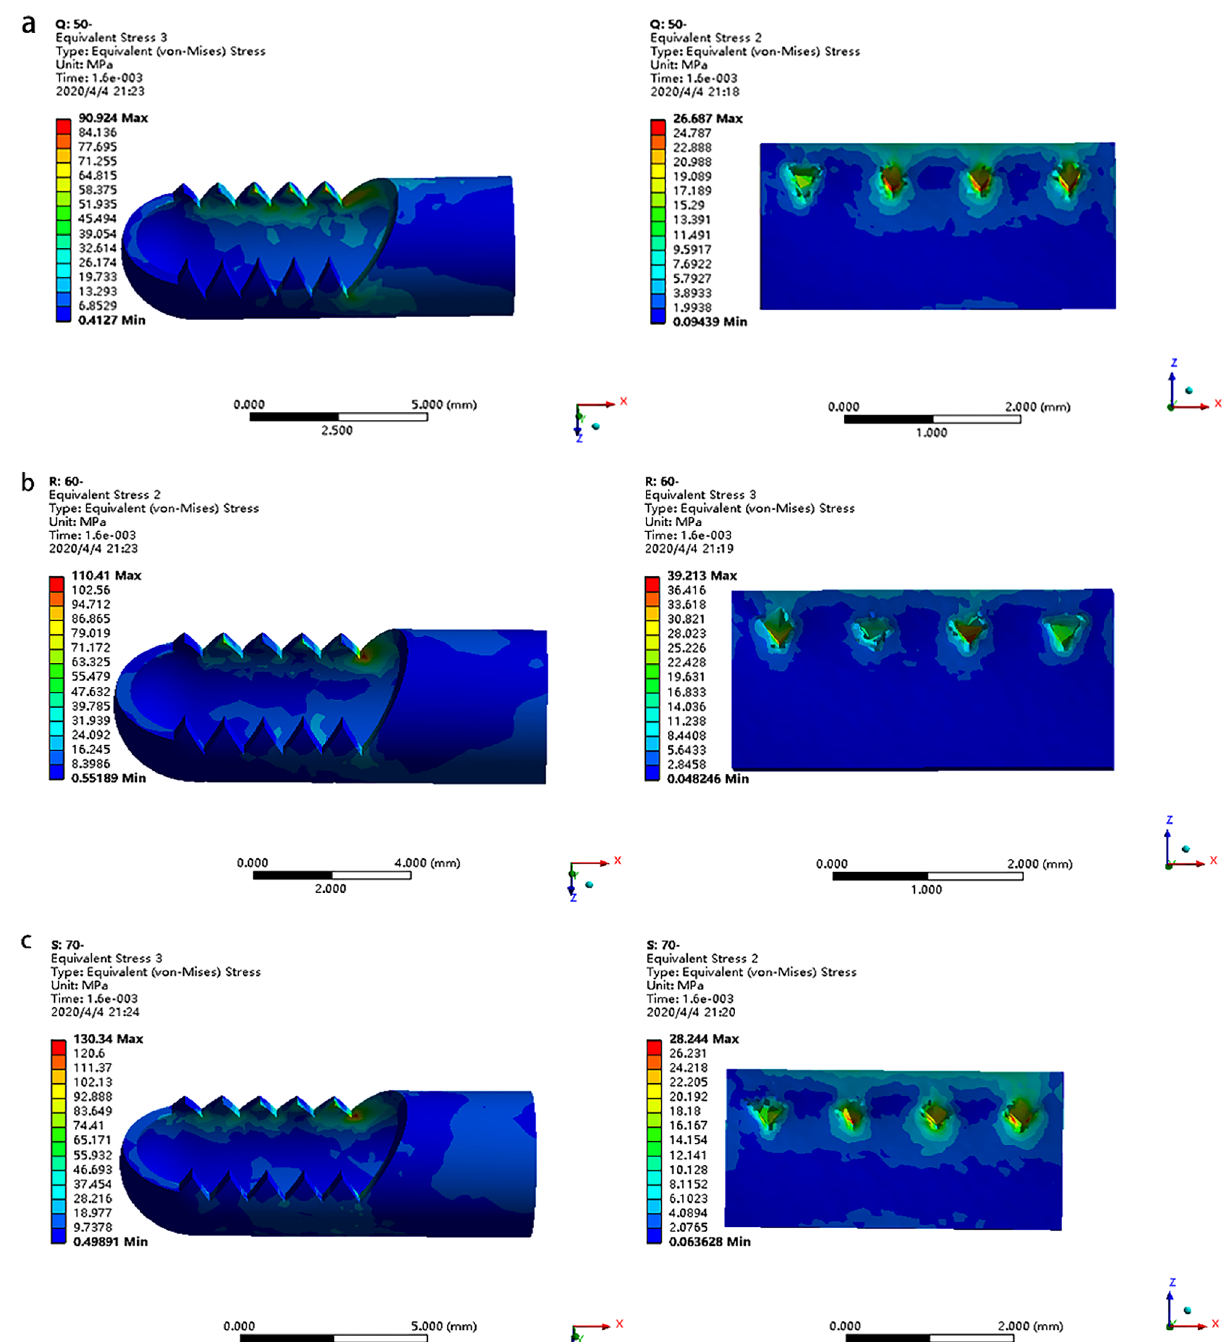
Figure 4. The stress distribution of the shaver and soft tissue when the outer sheath of the shaver with different tooth shapes is used to cut soft tissue: ( a ) 50° tooth profile, ( b ) 60° tooth profile, ( c ) 70° tooth